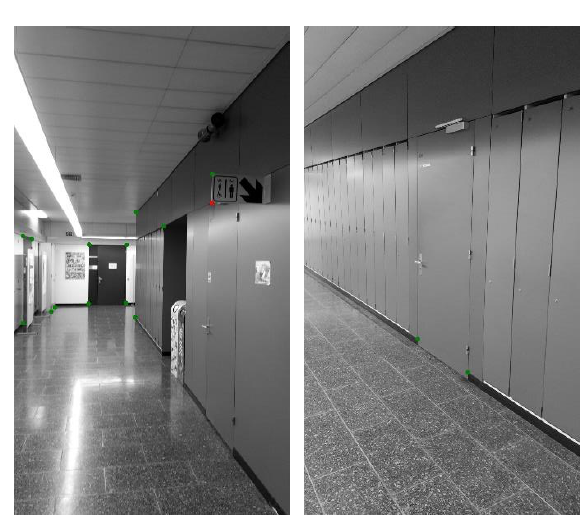
Figure 11. Images 255 (left) and 257 (right) overlaid with the reprojected checkpoints. Images converted to greyscale for better visibility of